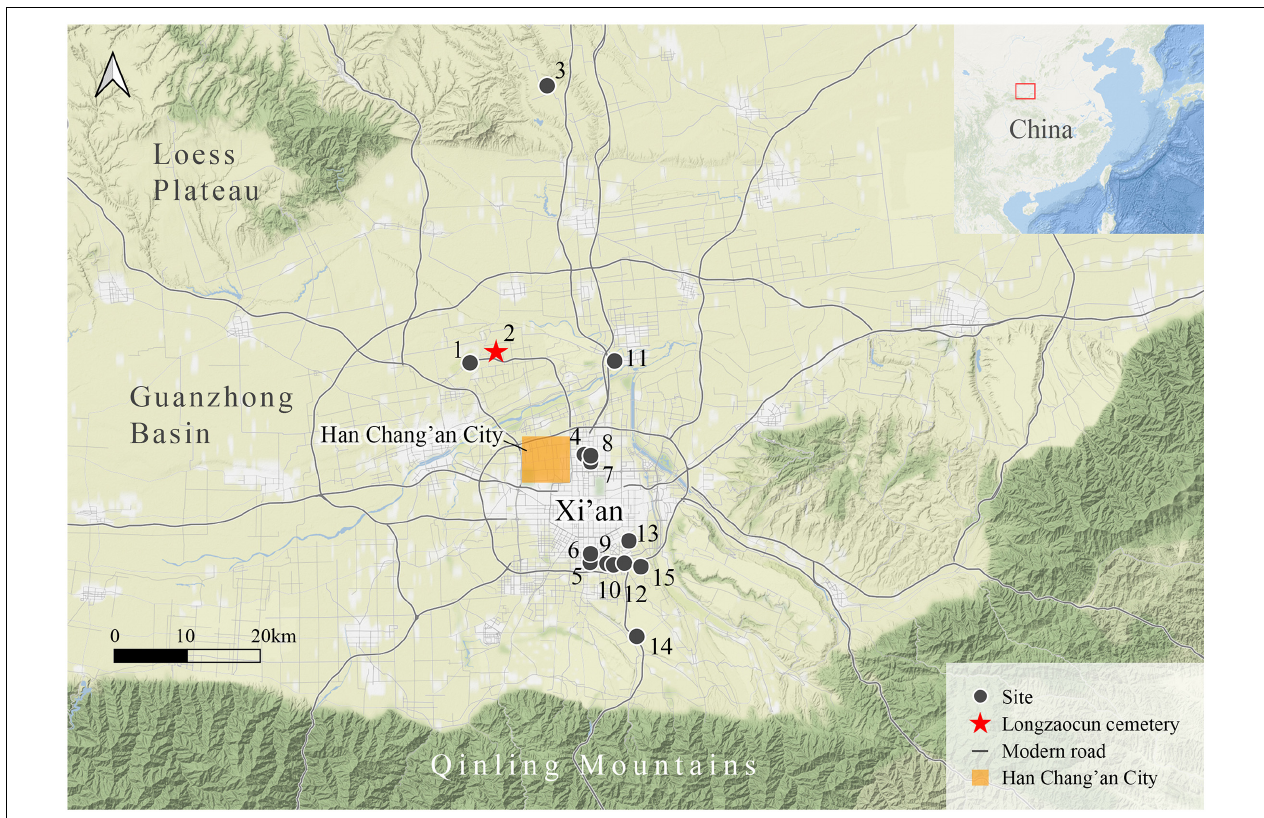
FIGURE 1 | Location of the Longzaocun cemetery and other related archeological sites around Han Chang’an City in Xi’an. (1) Jichang; (2) Longzaocun; (3) Guandao; (4) Ronghai; (5) Shijia; (6) Shiyou; (7) Hairong; (8) Jiaoxiao; (9) Yannan; (10) Quchun; (11) Guangming; (12) Yanhu; (13) Ligong; (14) Xizha; (15)